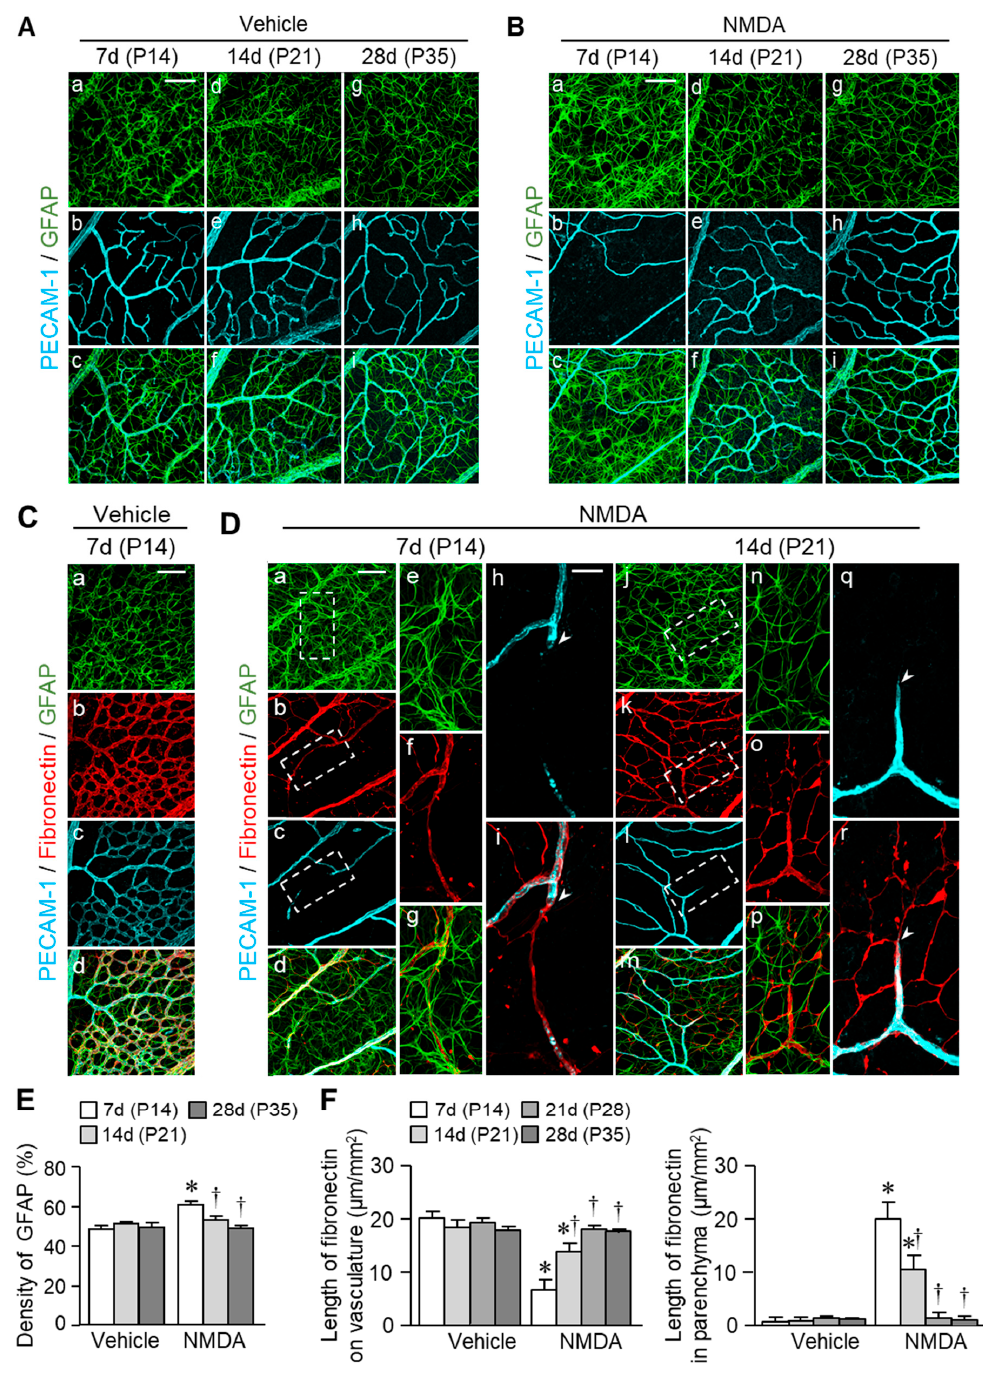
Figure 5. Changes in the distribution of astrocytes and fibronectin in the retinas of rats intravitreally injected with vehicle or NMDA. ( A – D ) Confocal microscopy images of retinal whole-mounts stained for astrocytes (GFAP), fibronectin, or endothelial cells (PECAM-1) 7 (P14), 14 (P21), and 28 days (P35) following intravitreal injection of vehicle ( A , C ) or NMDA (200 nmol; B , D ). In panel D, higher-magnification images of the insets are shown in the panels De-i and Dn-r. Scale bars = 100 µ m in Aa (applies to Ab–f), 100 µ m in Ba (applies to Bb–i), 100 µ m in Ca (applies to Cb–d), 100 µ m in Da (applies to Db–d and Dj–m), and 30 µ m in Dh (applies to Di, Dq, and Dr). ( E , F ) Quantification of the area density of GFAP ( E ), and the length of fibronectin on blood vessels and in retinal parenchyma in the central retinal area ( F ). * p < 0.05 vs. the corresponding age-matched control value (vehicle). † p < 0.05 vs. the corresponding 7 days value after the injection. n =